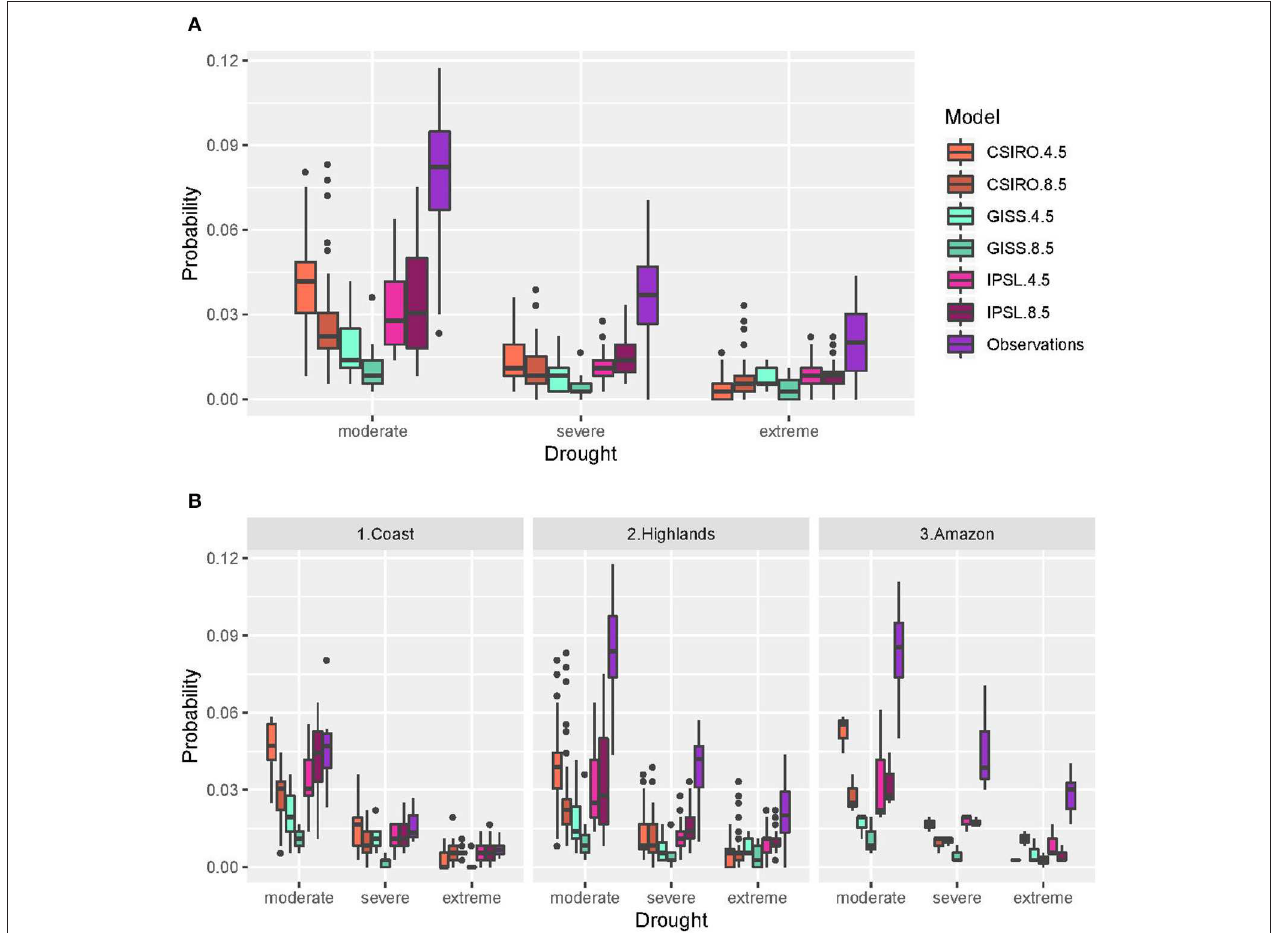
FIGURE 3 | Future probability of drought occurrence at observations points. (A) for the whole country, (B) for each region.